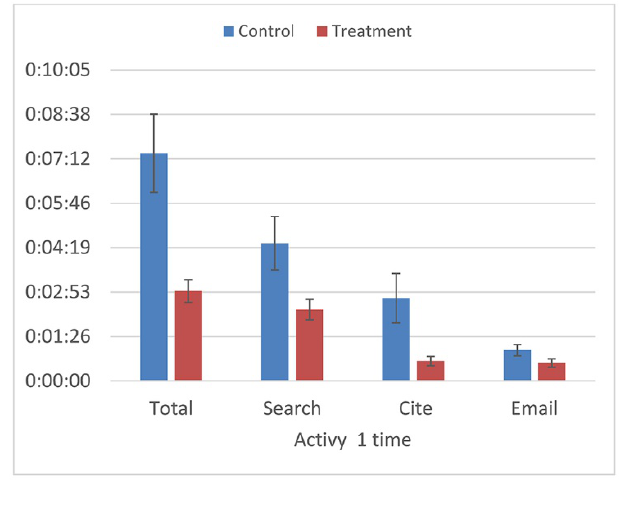
Figure 1 Time on task for control and treatment groups